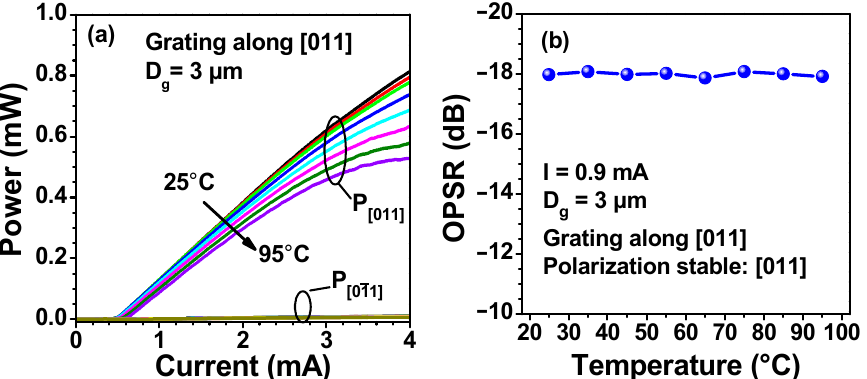
Figure 7. Light-current (L-I) characteristics ( a ) and OPSR at an injection current of 0.9 mA ( b ) of a surface grating VCSEL at different temperatures. The period and depth of the surface grating are 500 nm and ~150 nm, respectively.